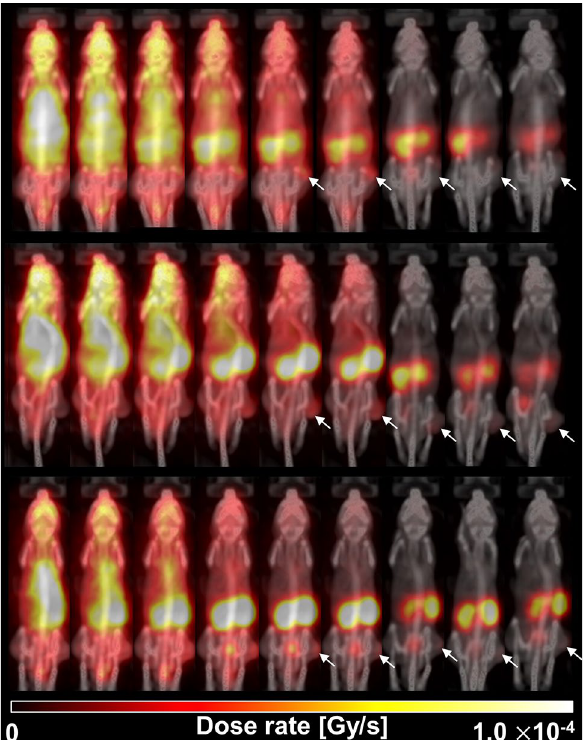
Figure 3. Dose map of [ 68 Ga]PSMA-11 in the subcutaneous prostate cancer xenograft model mice ( n = 3, each row) at various time-points (from left to right in each column: 2, 5, 10, 30, 60, 90, 180, 240, 300 min p.i., respectively) after the intravenous injection of [ 68 Ga]PSMA-11. The arrows indicate the PSMA-positive tumor (22Rv1).